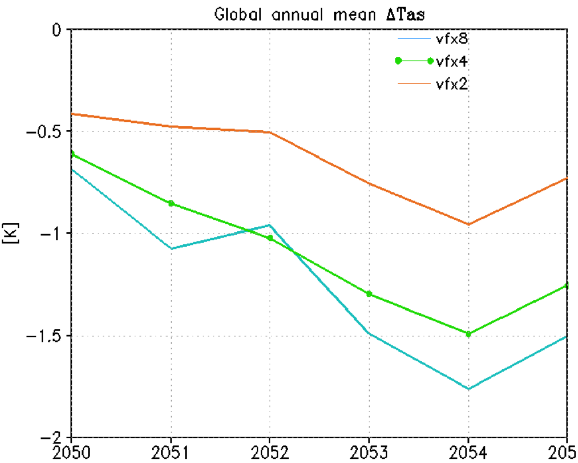
Figure 5. Zonally averaged annual mean of the difference in rela- tive humidity (%) from NorESM1-ME for an octupling of the cirrus ice crystal fall speed. Differences are calculated as an average over years 2050–2055 against a background of